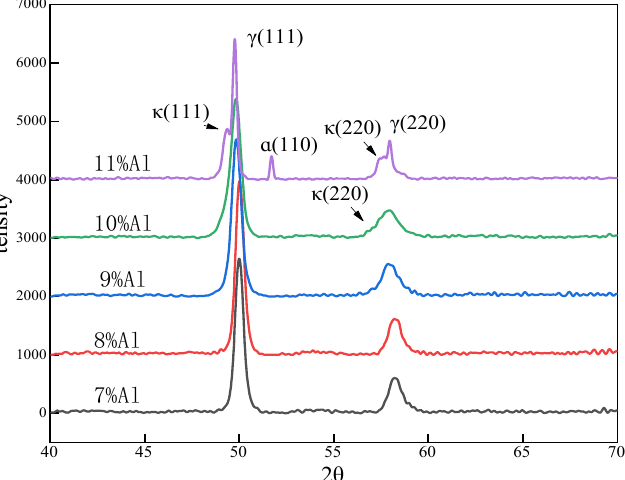
Figure 3. X-ray diffraction of furnace-cooling samples with different Al addition.